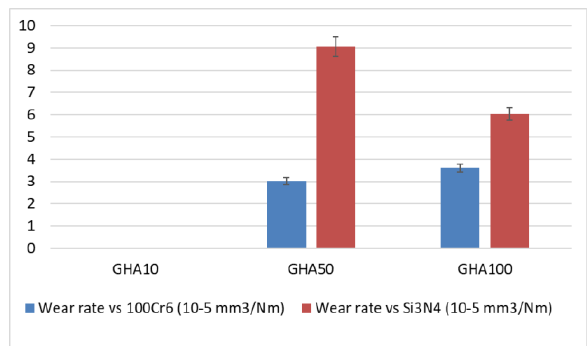
Figure 9. Values of the specific wear rate calculated for the samples, after sliding against 100Cr6 (blue columns) and Si 3 N 4 (red columns) counterbodies.